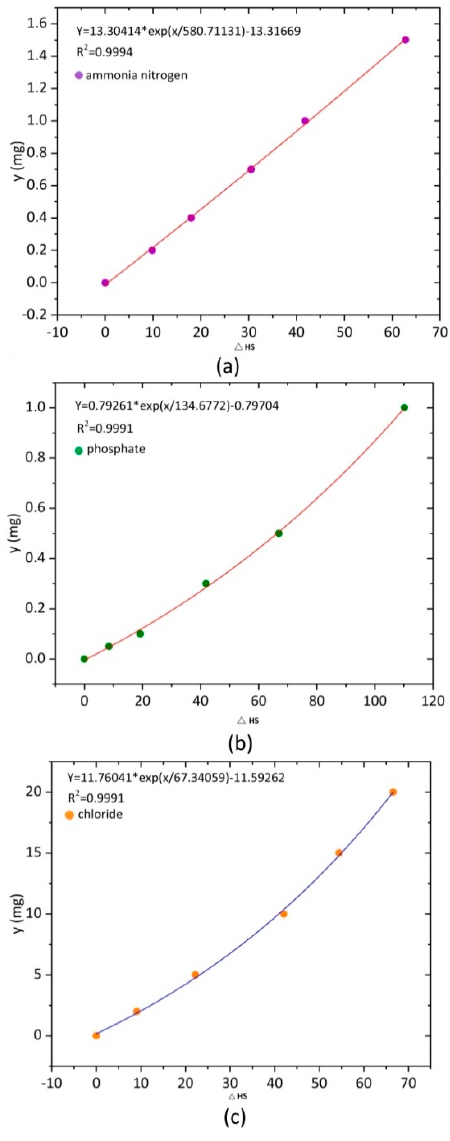
Figure 13. Fitting curve and result of soluble content in water. ( a ) is the fitting curves of ammonia nitrogen. ( b ) is the fitting curves of phosphate. ( c ) is the fitting curves of chloride.